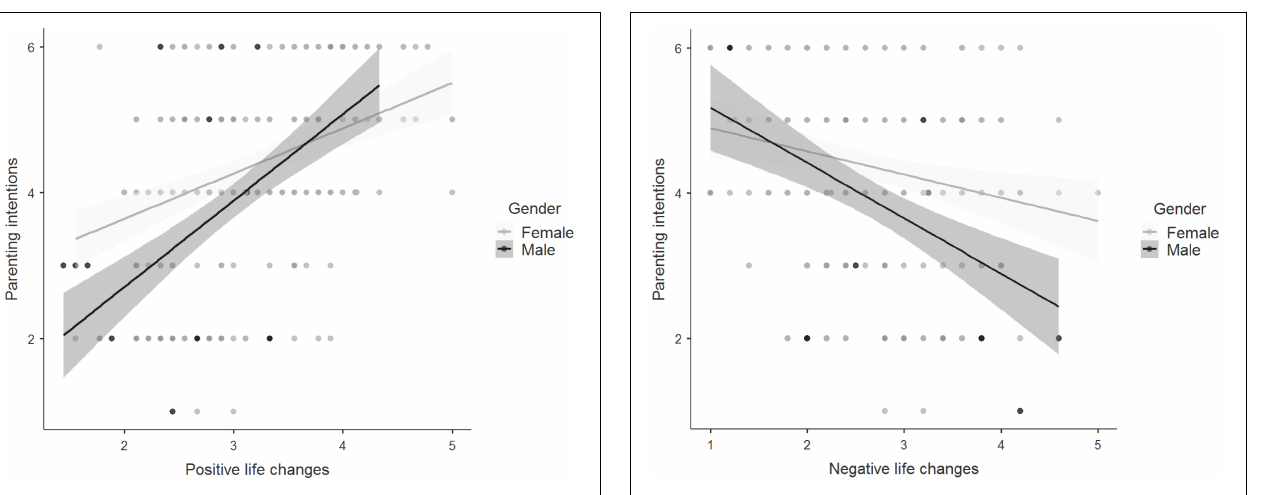
FIGURE 3 | Regression plot showing the relationship between perceived positive life changes in connection with becoming a parent and the strength of parenting intentions among men and women. Points represent individual responses, n = 269 and the gray shaded region represents the 95% confidence region. For perceived positive life changes, responses were on 5-point Likert scale with higher scores indicating more positive expectations of future parenthood. For the strength of parenting intentions, responses were on 6-point Likert scale with higher scores indicating a stronger intent to become a parent.